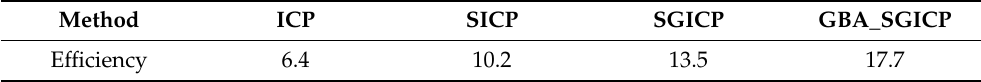
Table 2. Impact of cloud alignment algorithm on mapping efficiency (unit: km/h).